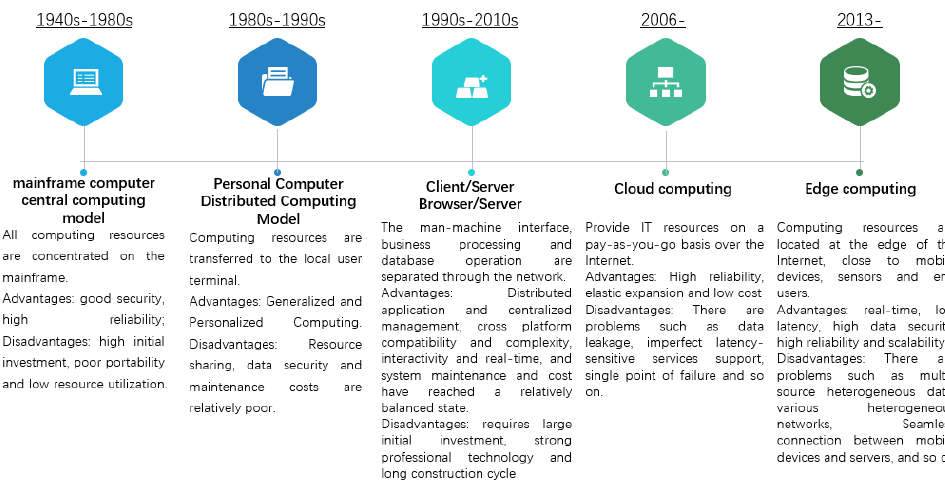
Figure 1. The development road map of the ICT’s main computing